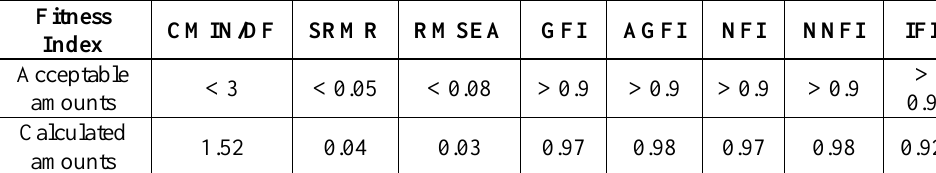
Table (2) Goodness of fit indices model of bias role on auditors’